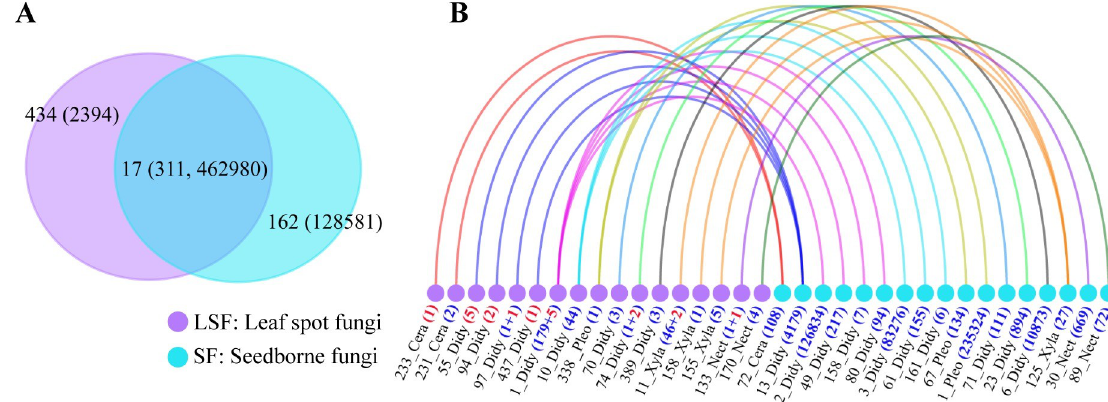
Fig 2. Shared OTUs between leaf spot fungi and seedborne fungi. (A) Venn diagram for the number of unique and shared OTUs between leaf spot and seed libraries. The number in parentheses represents the abundance of isolates (for leaf spot fungi, LSF) or sequence reads (for seedborne fungi, SF). The 17 shared OTUs were represented by 311 isolates of leaf spot fungi and 462980 reads of seedborne fungi. (B) Network diagram for the 17 shared OTUs between the leaf spots and the seeds. The lines depict the associations of shared OTUs between leaf spot fungi and seedborne fungi. The abbreviations following each OTU number in the corresponding library represent the family name; Didy, Didymellaceae; Xyle, Xylariales; Nect, Nectriaceae; Pleo, Pleosporaceae; Cera, Ceratobasidiaceae; the numbers in parentheses represent the abundance of isolates (for leaf spot fungi, the number of nonpathogenic fungi is shown in red) or next-generation sequencing reads (for seedborne fungi). Because the ITS sequence obtained by next-generation sequencing technology is short (~250 bp), the alignment is trimmed to this range and clustered to generate novel OTUs. This trimming causes a few OTUs to merge in both libraries, for example, OTU 1_Didy in leaf spot fungi and OTU 125_Xyla in seedborne fungi (see 4.4 Investigation of seedborne fungi of A . adenophora ).